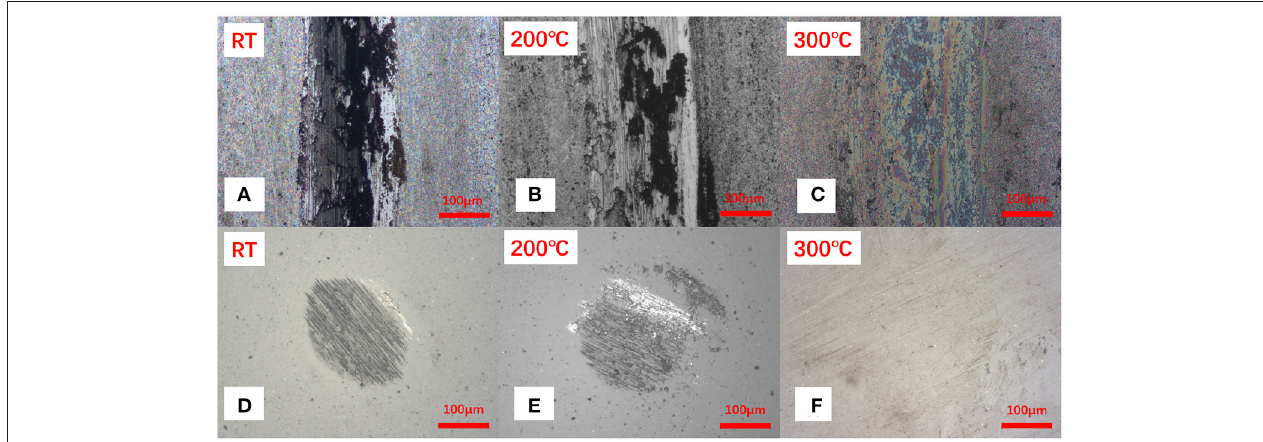
FIGURE 5 | The optical images of (A–C) worn tracks, (D–F) corresponding ball worn surfaces for the Sb 2 O 3 -MSH/C sample after the tribotests performed under different temperature